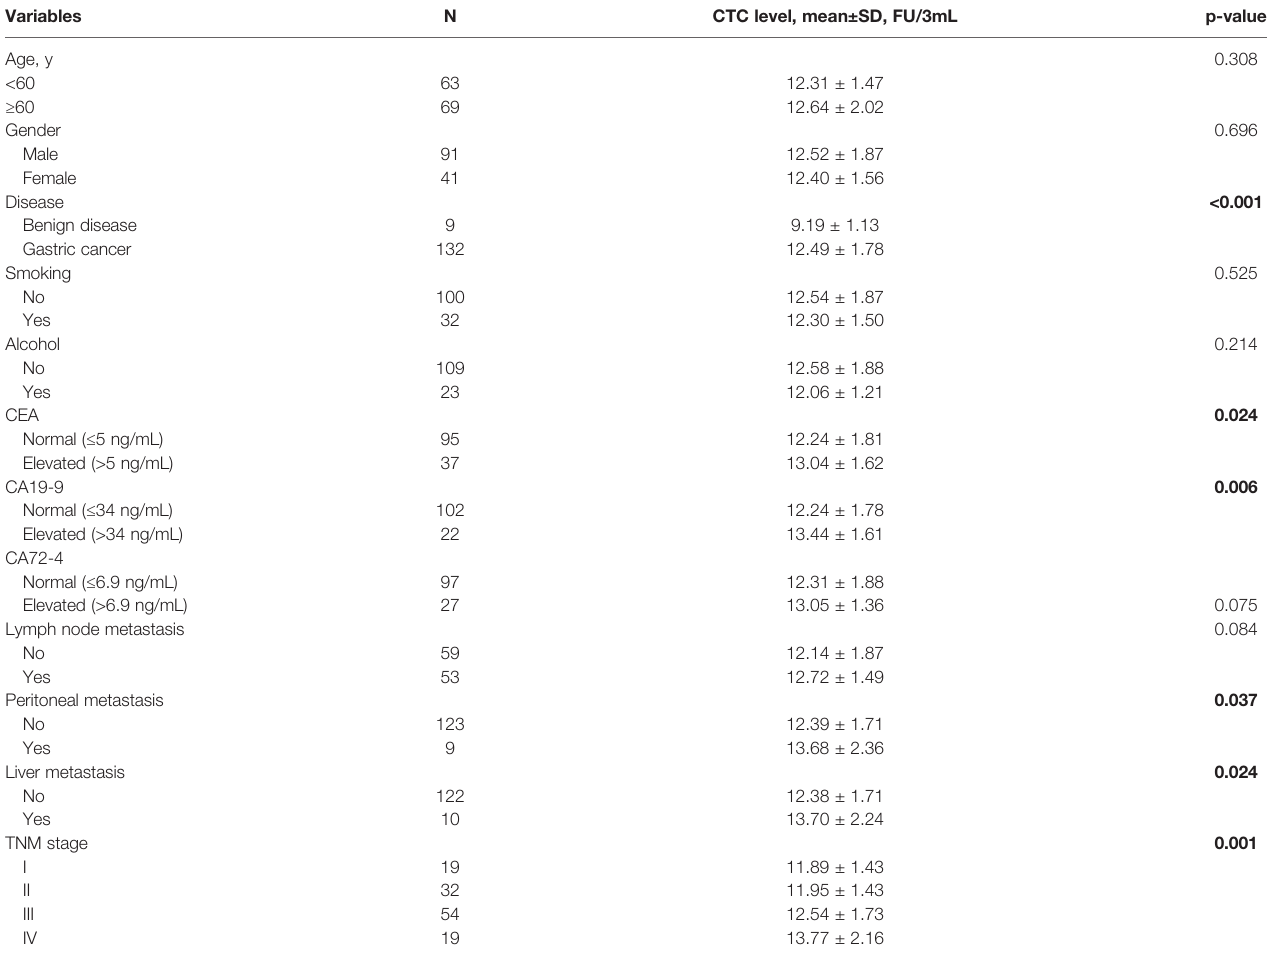
TABLE 2 | CTC level in patients grouped according to different clinical characteristics (n = 132).